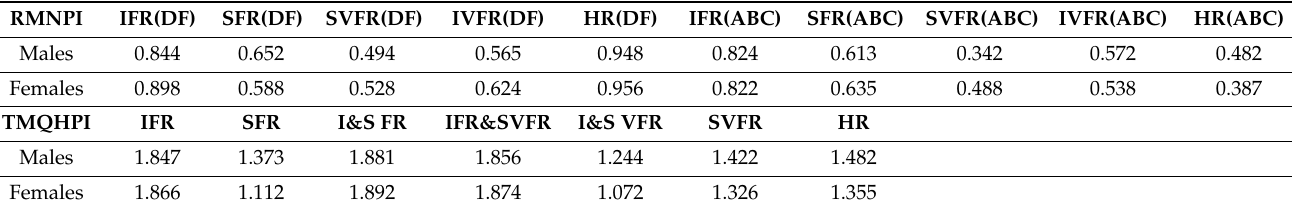
Figure 12. The regression line for male and female study group, applying the Navy plaque index modified by Rustogi. Table 1. RMNPI and TMQHPI in male and female